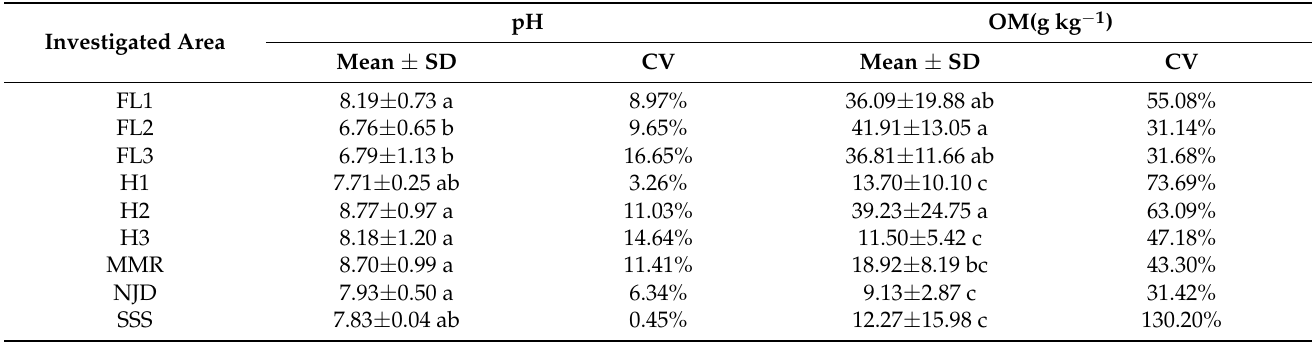
Table 1. pH and OM contents in different